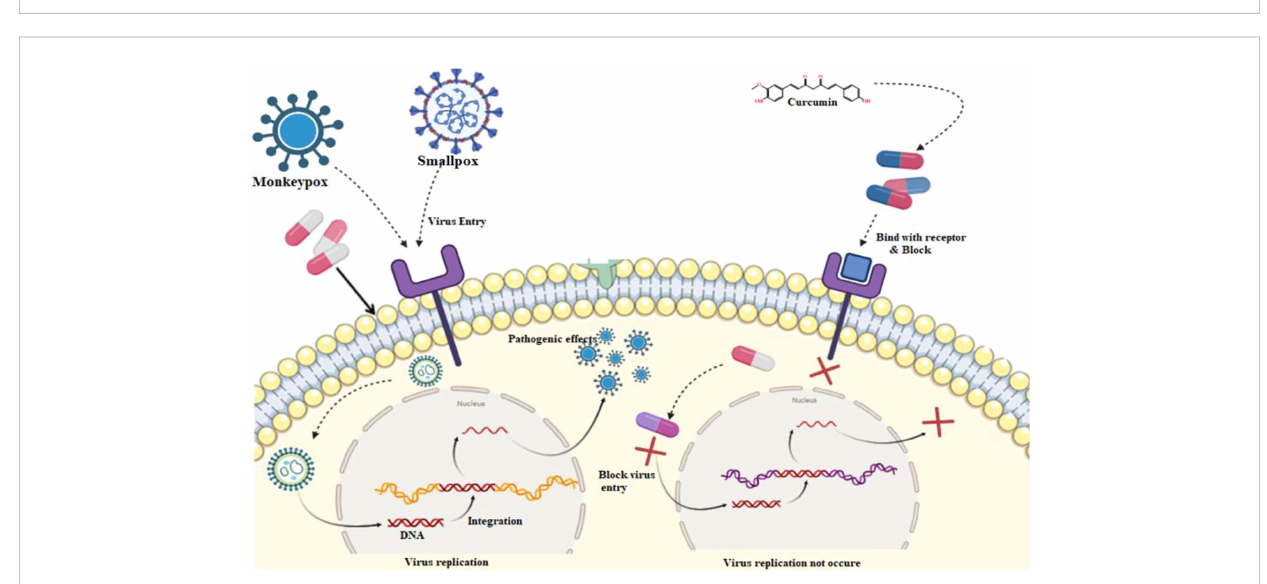
FIGURE 3 Chemical structure of curcumin and its derivatives.